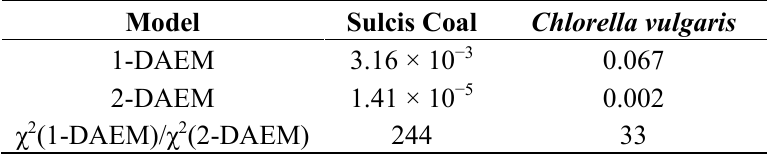
Table 6. Summary for the Residual Sums of Squares for the two